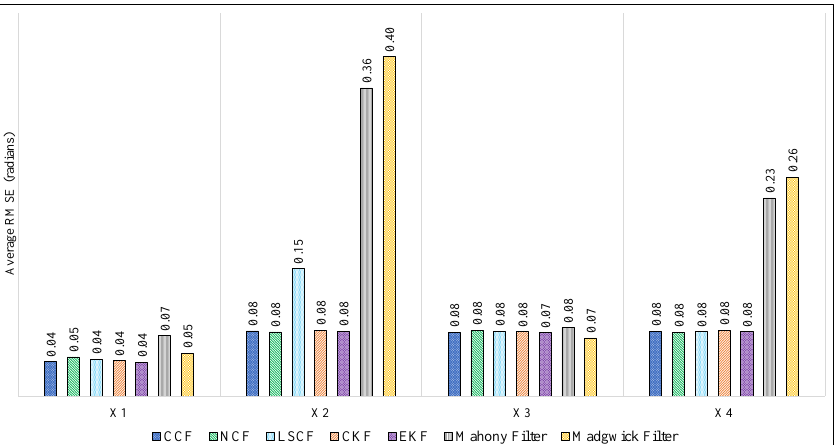
Figure 10. Comparison of proposed CCF structure with other estimation algorithms on Xsense